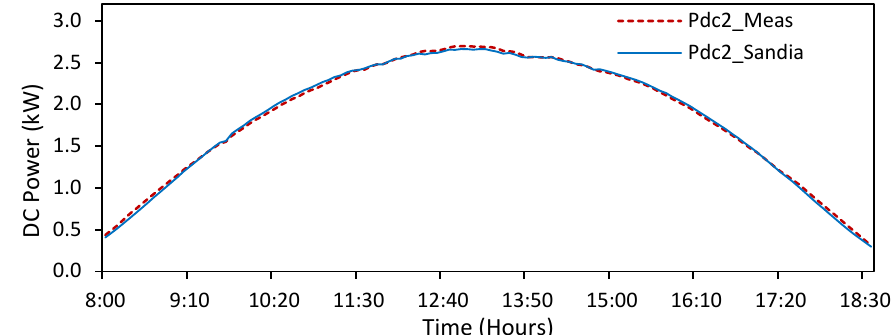
Figure 11. Measured and simulated maximum power of the PV sub-array N°2. Table 10. Regression metrics of DC Power simulated for three sub-arrays. Metrics/Param.